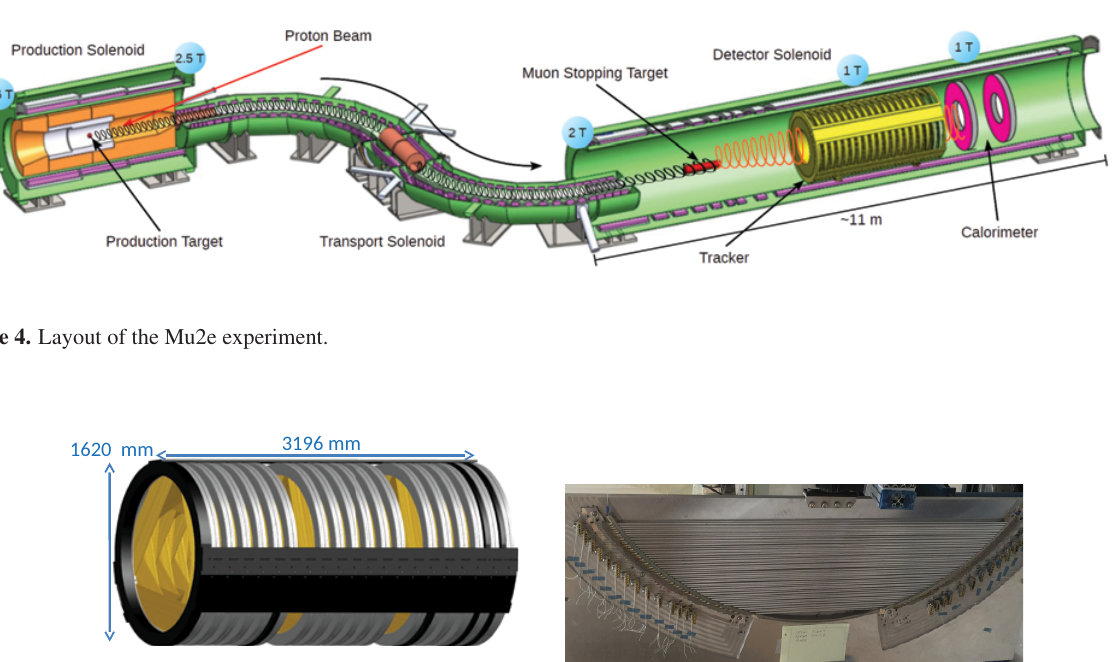
Figure 5. (Left) Sketch of the Mu2e straw tracker system. (Right) Picture of the first prototype built for straw tube